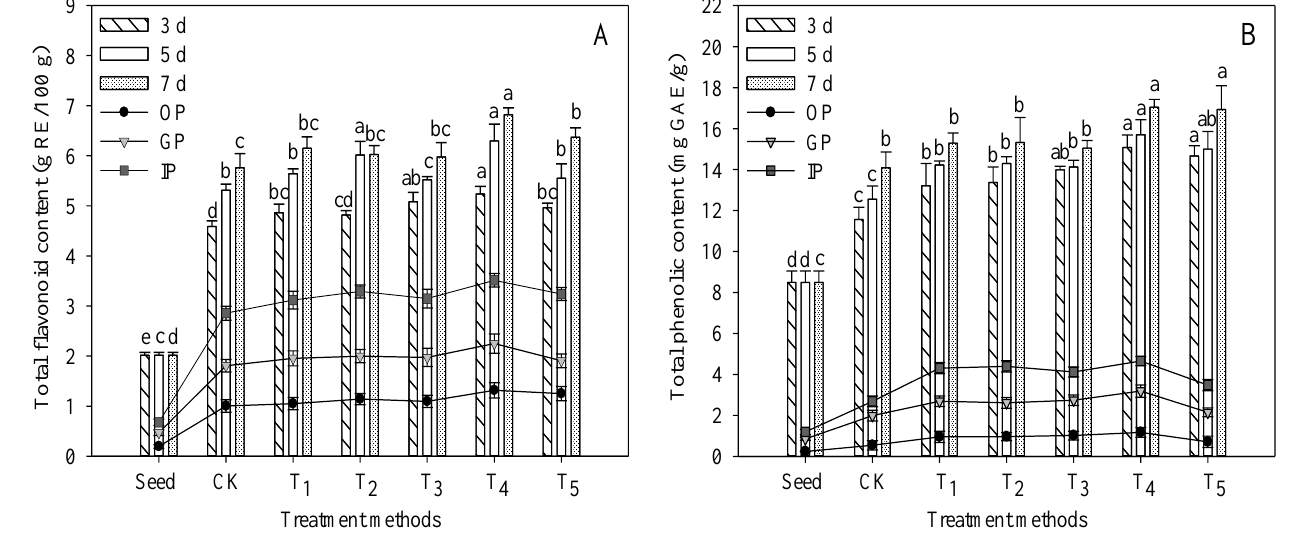
Figure 5. Effects of in vitro digestion on TP and TF contents of TB sprouts. OP, oral phase; GP, gas-